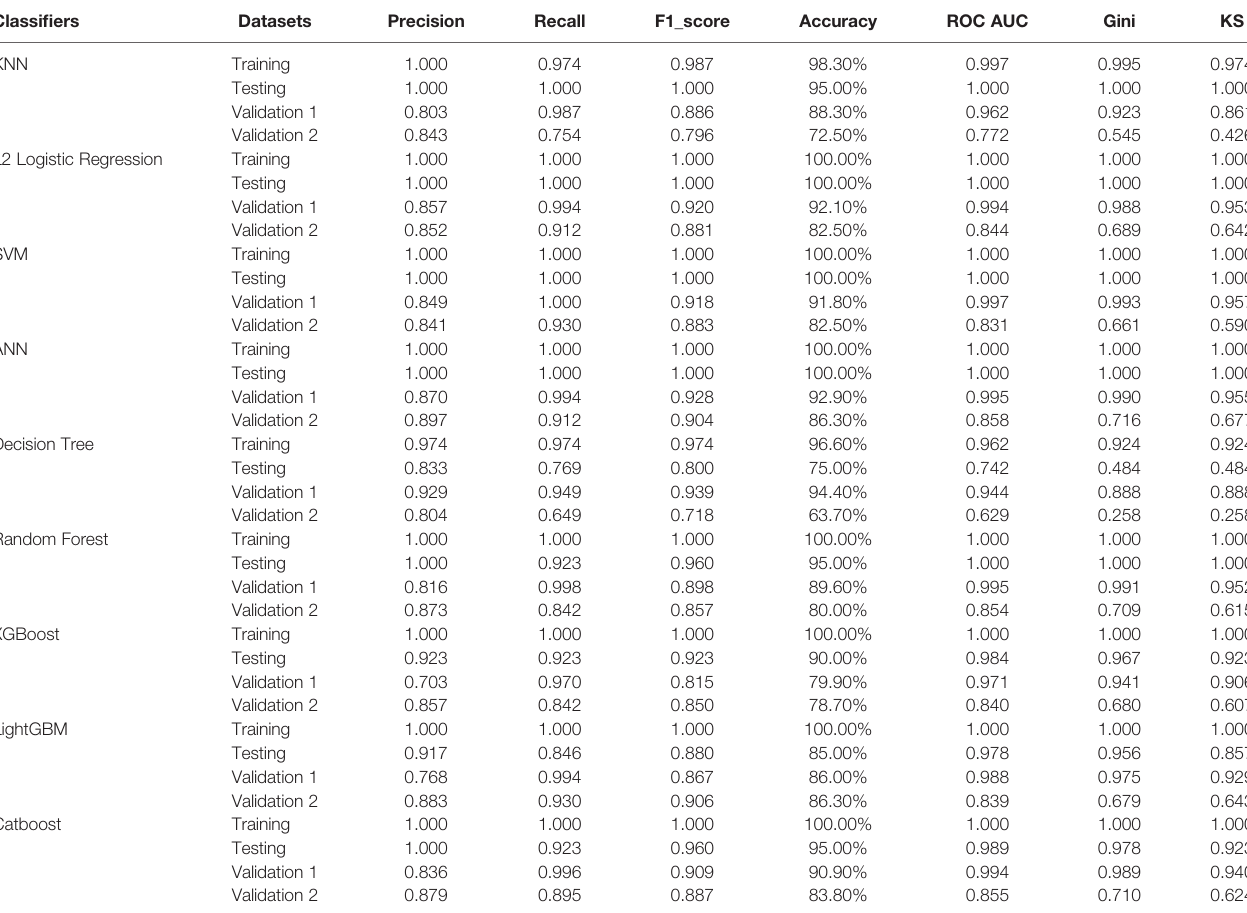
TABLE 1 | Evaluation parameters of classi fi ers in different datasets. Classi fi